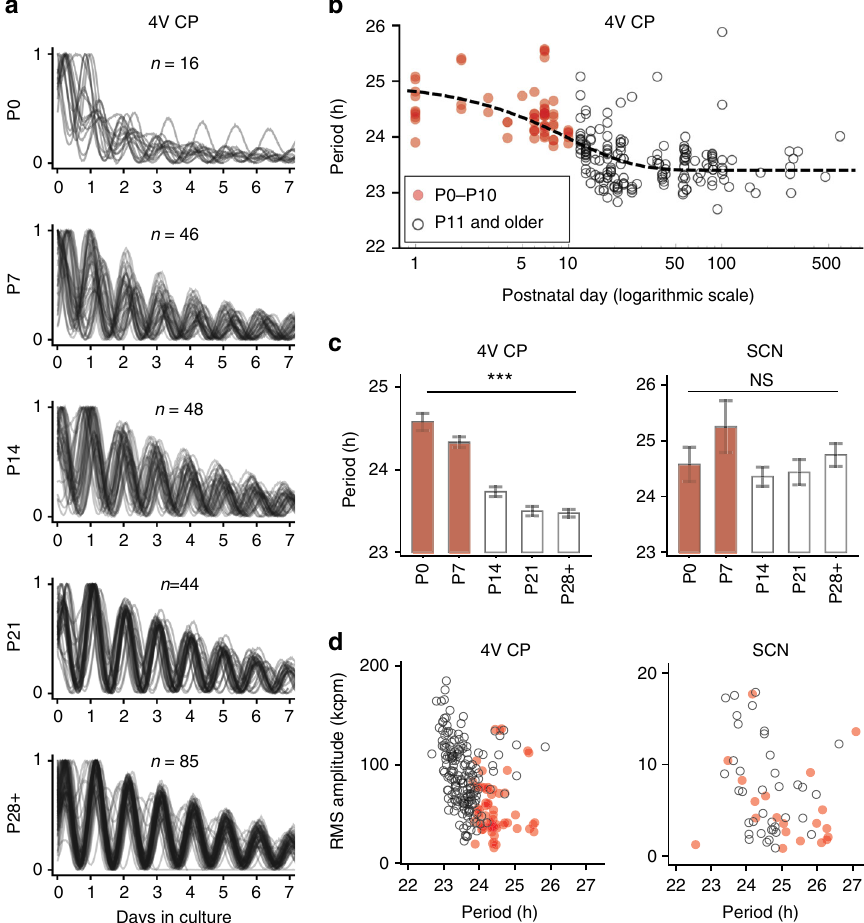
Fig. 4 Increased synchrony and decreased period of the CP circadian clock occur during development. a Overlays of PER2::LUC oscillations from 4V CPs of different animals at increasing postnatal days (toward the bottom), with the initial point matched to the same hour, pooled from all control data used in this study ( n = 239). Oscillation becomes progressively more in phase with the external light – dark cycle as age increases, and becomes more robust, indicating internal synchrony within the tissue. These developmental changes are comparable to those in the SCN in which the PER2::LUC oscillation becomes less robust past P14 40 . The number of samples (animals) is indicated in each panel. b Summary of the developmental change of circadian period of PER2::LUC oscillation. The dashed line indicates an exponential fi t with a characteristic time of postnatal day 9.47 (period = 1.58 e − t /9.47 + 23.41 h). c Past the critical age between P7 and P14, the increasing speed of the CP clock stabilizes ( *** P0 vs P7 – P28 + : p = 0.0026, p = 1.8 × 10 – 7 , p = 2.2 × 10 – 8 , p < 4.5 × 10 – 9 ; Mann – Whitney test) which is not observed in the SCN ( n = 58). Error bars indicate SEM. d In the CP, the P0 – P7 group (red dots) falls into the long-period and low-amplitude quadrant, while the >P14 group (open circles) distributes in the short-period and high-amplitude quadrant along the inverse period- amplitude trend (left), while in the SCN such age dependency is absent (right). Both the CP and the SCN show an inverse relationship between the period and the amplitude, while the CP show a stronger relationship even when the sample size is controlled (CP: R = − 0.43 ± 0.13, p = 5.89 × 10 – 4 ; SCN: R = − 0.28 ± 0.14, p = 0.023). Amplitudes are rescaled by half when both left and right sides were cultured